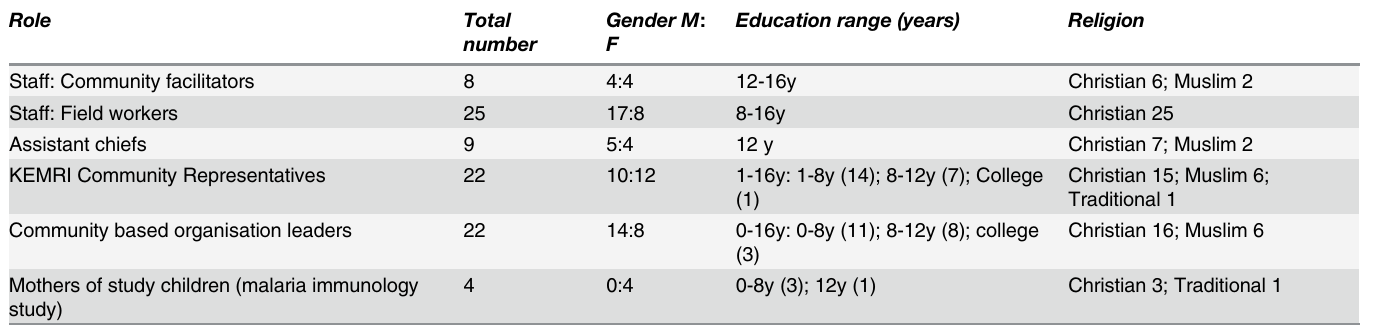
Table 1. Summary information for